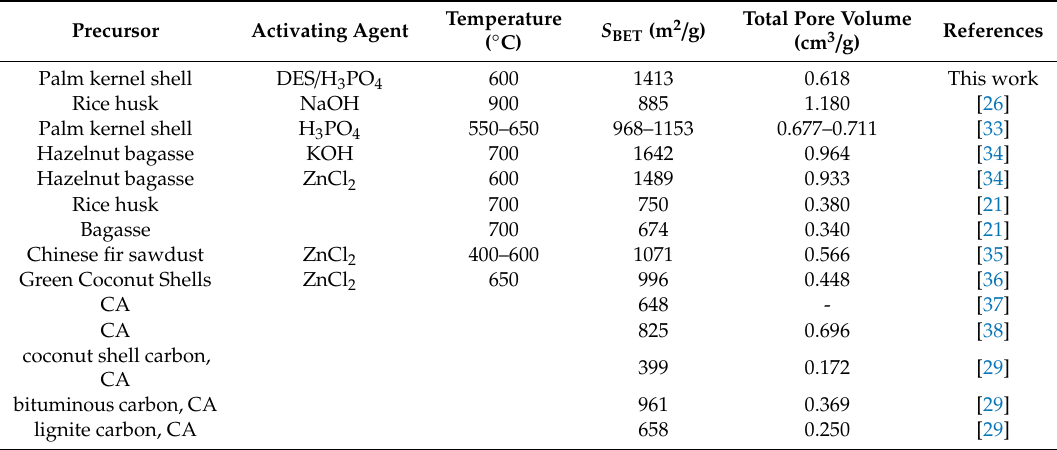
Table 2. The surface textural properties of the prepared active carbons (ACs) were compared with similar carbon materials obtained from di ff erent agricultural waste.